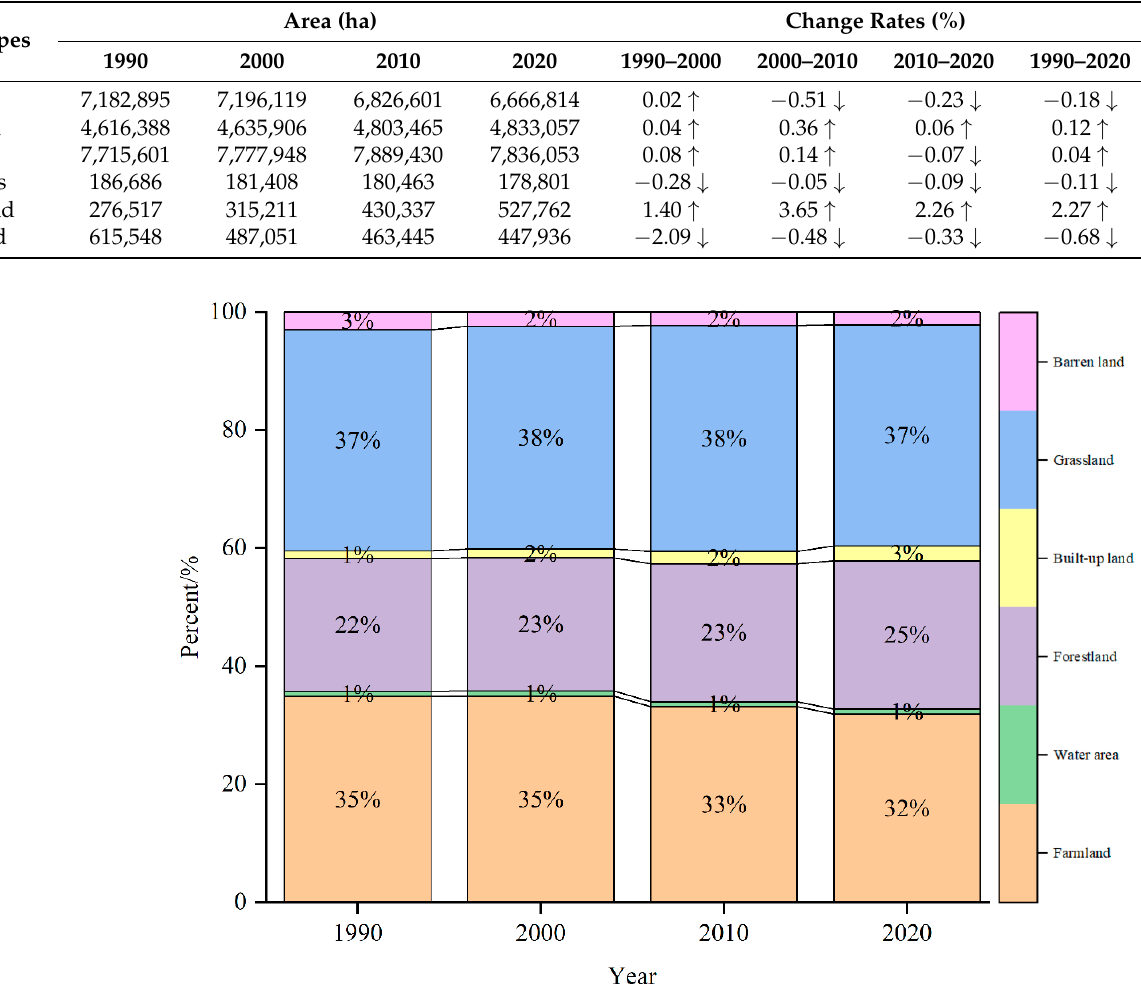
Figure 2. Proportions of land-use types in Shaanxi Province from 1990 to 2020. From the perspective of spatial change, farmland is mainly concentrated in the central region (Figure 3). With the implementation of the project and urbanization, farmland showed a decreasing trend. Forestland showed an increasing trend, concentrated in south- ern Shaanxi and the central mountainous areas. Grassland is in a dynamic process, mainly distributed in northern Shaanxi. Water areas are relatively modest, with little change, and are primarily spread along rivers. Barren land is primarily dispersed in northern Shaanxi’s sandy area and has been steadily shrinking since the project was implemented. The most vis- ible trend is the increase in built-up land centered in central Shaanxi Province and the cities’ core regions. Built-up land is encroaching into farmland, grassland, and forestland around cities and rural regions, linked to urban population increases and accelerated urbanization.